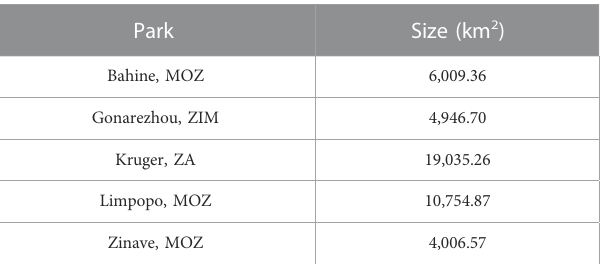
TABLE 1 Park name, country location and